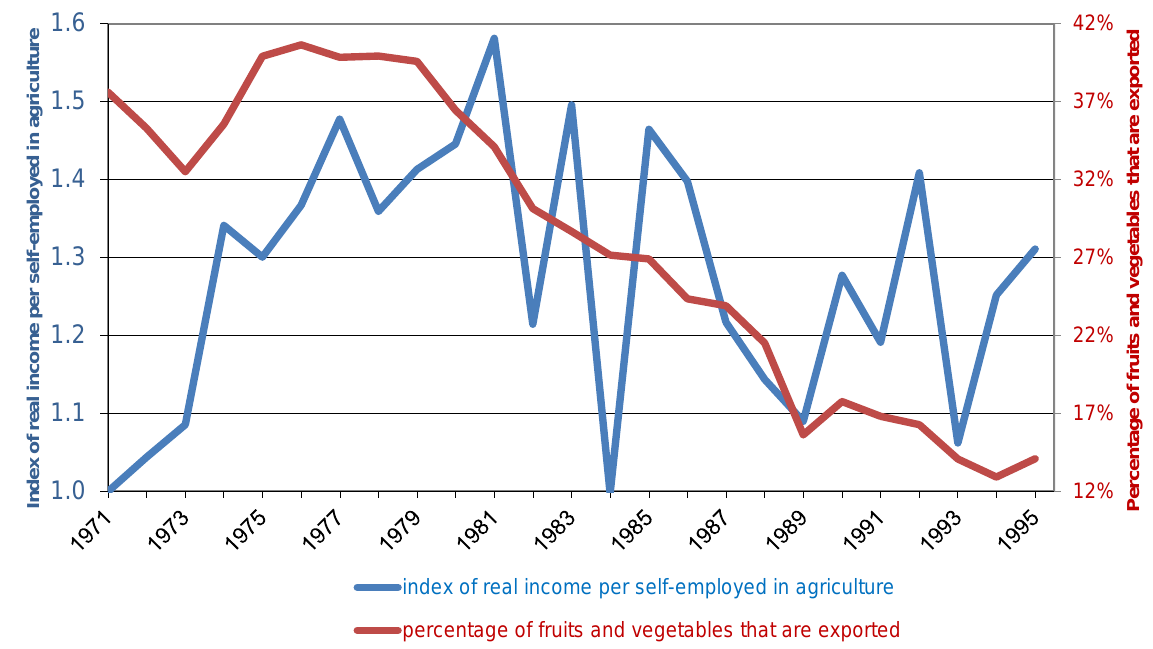
Figure 3. Changes in the income of farmers and the fraction of fruits and vegetables that are exported.